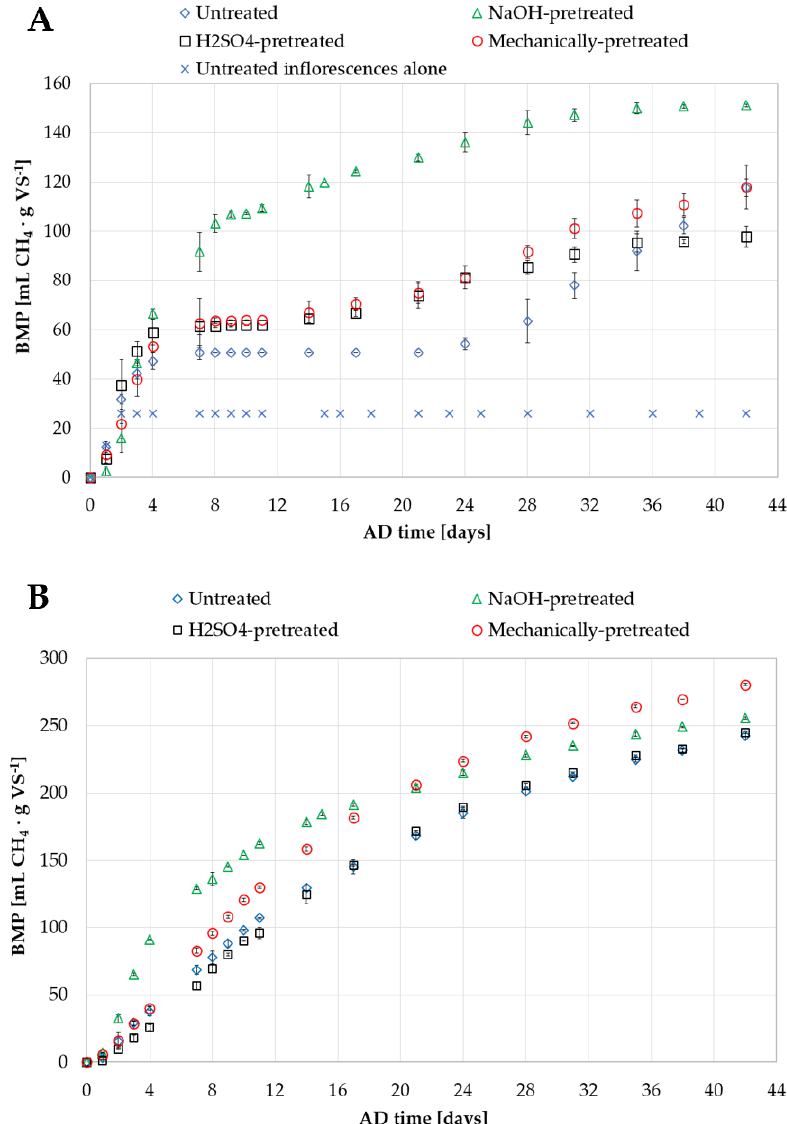
Figure 3. ( A ): Evolution of the cumulative biomethane profiles obtained with the untreated ( ◇ ), NaOH-pretreated (Δ), H 2 SO 4 -pretreated (□) and mechanically pretreated ( ○ ) mix of leaves and inflorescences. The cumulative biomethane profile obtained with the untreated inflorescences alone is also shown (×). ( B ): Cumulative biomethane profiles obtained with the NaOH-pretreated (Δ), H 2 SO 4 -pretreated ( ◇ ) and mechanically pretreated ( ○ ) retted hurds. The cumulative biomethane profile of untreated retted hurds (□) refers to that already reported by Papirio et al. [27]. The lines on the symbols indicate the standard error bars. AD time: anaerobic digestion time.